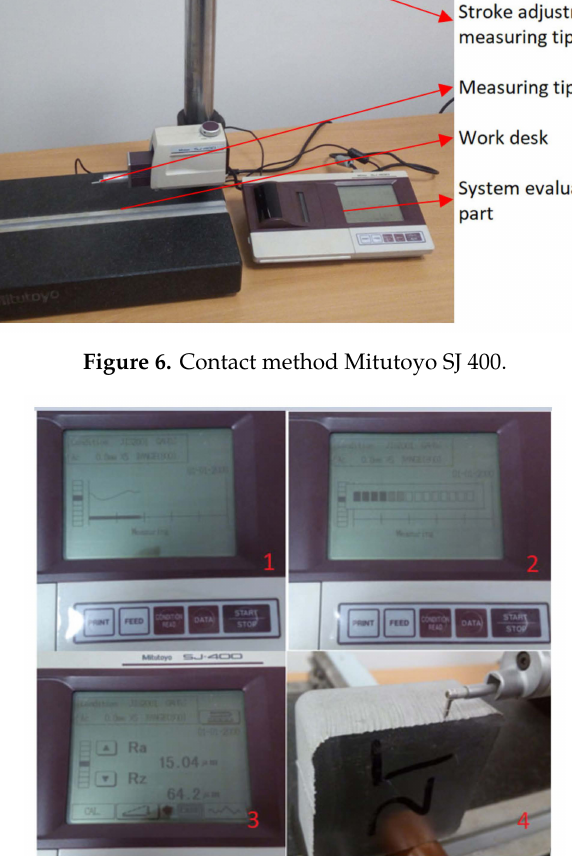
Figure 7. Mitutoyo SJ 400 software and hardware (1. Measuring phase, 2. Evaluation phase, 3. Measurement values, 4. Movement of the tip over the surface of the